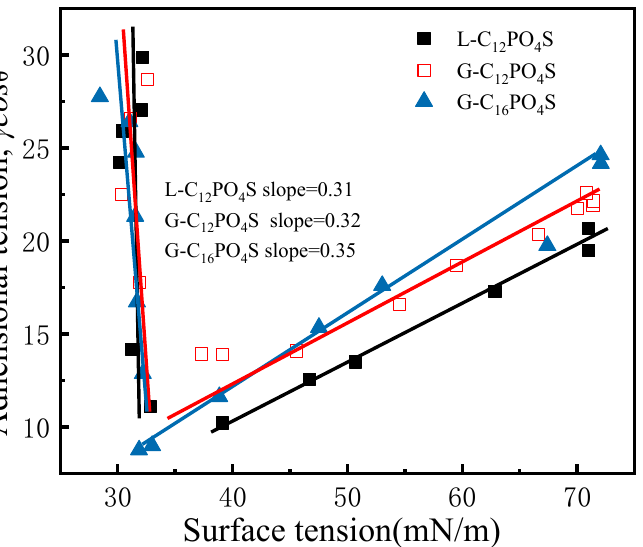
Figure 3. Dependence between the adhesional tension and surface tension of the extended surfac- tants.